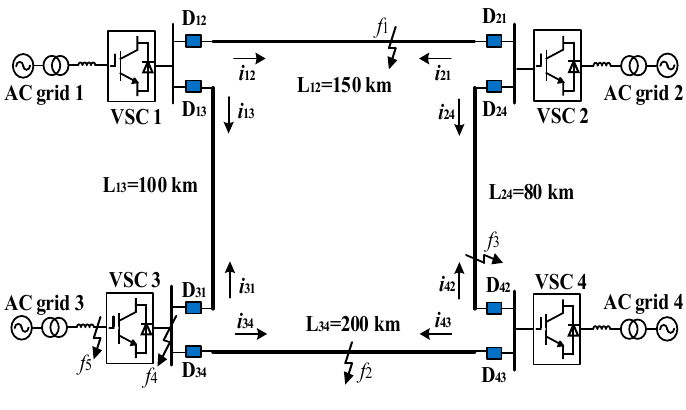
Figure 8. Fault simulation model.